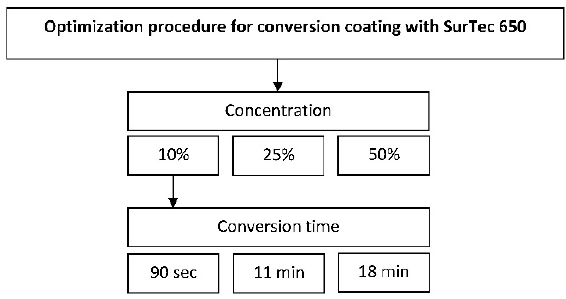
Figure 4. A schematic presentation of the selection of deposition conditions of conversion coating SurTec ® 650 on the AA3003 substrate.